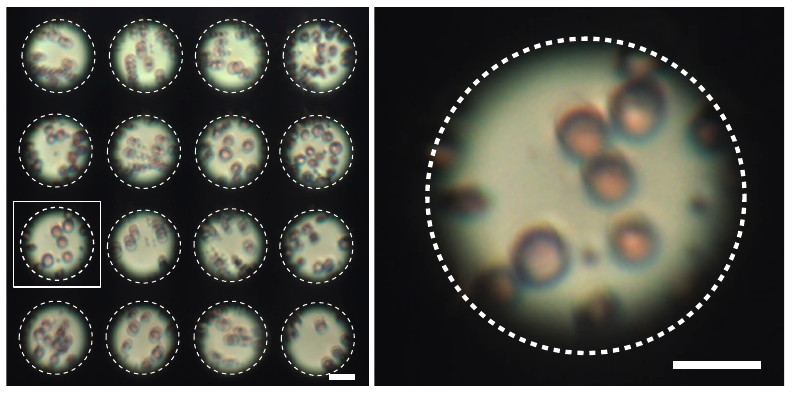
Figure 10. Left image : Imaging a blood smear using the entire µOIL chip (from all 16 ball mini-lens). The magnification of the stereo microscope was set to 2×. Right image is the magnified version of the image from the lens in the square box shown in the left image. Scale bar: 20 µ